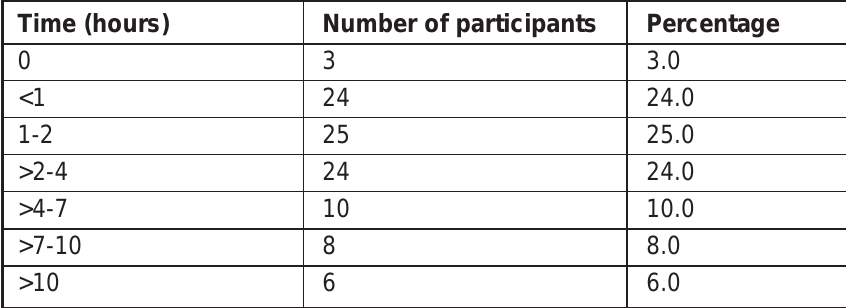
Table 5: Physiotherapy treatment time